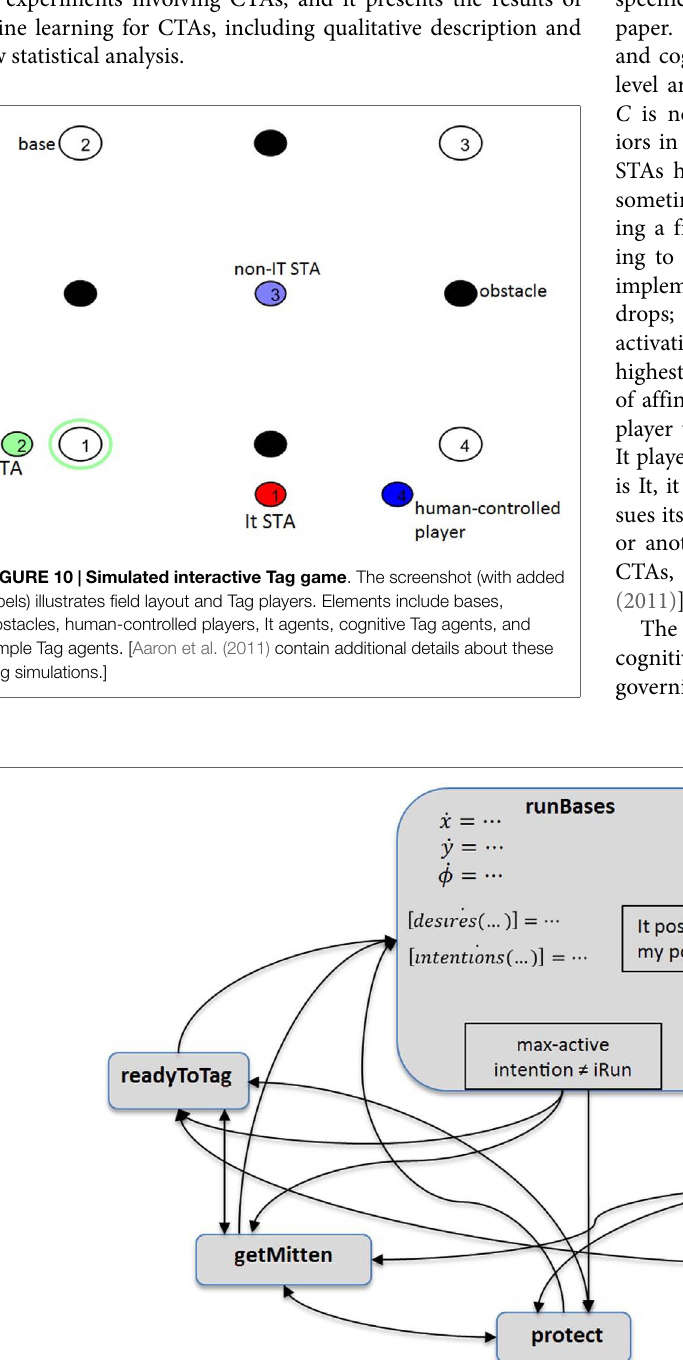
Frontiers in Robotics and AI |